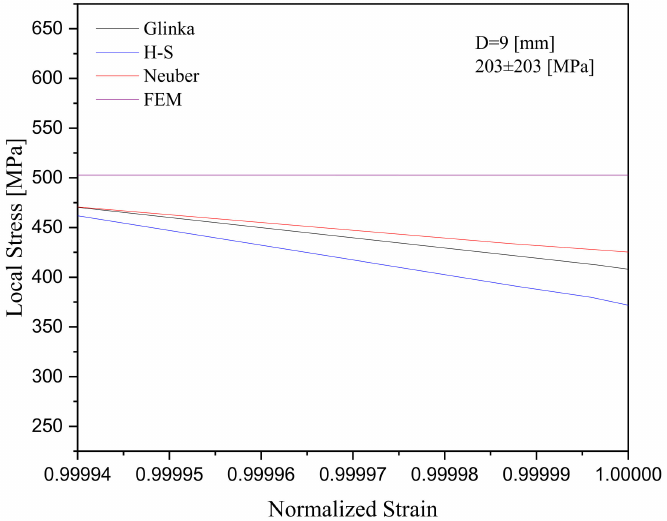
Figure 11. Stress relaxation for a steel specimen with a 9 mm notch diameter subjected to 203 ± 203 MPa, using three different rules coupled with the A-V kinematic hardening rule and through FE